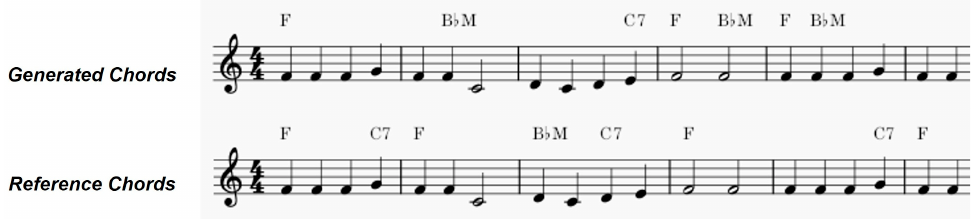
Figure 9. Leadsheets of given melody sequence with generated chords and reference chords.